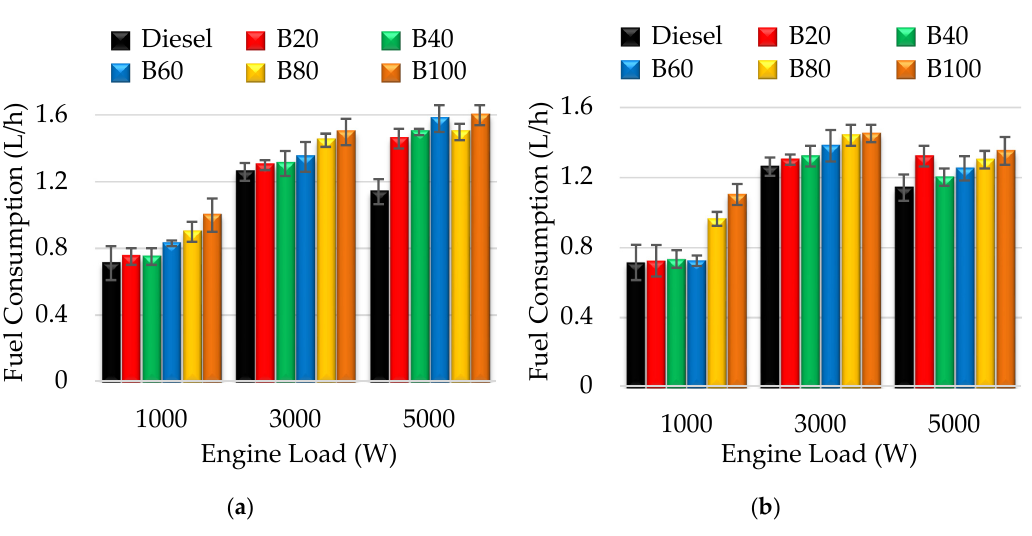
Figure 6. Fuel consumption values (L/h) at different engine loads (1, 3, and 5 kW) for ( a ) diesel/ethyl acetate/sunflower oil; ( b ) diesel/ethyl acetate/castor oil blends. The results are the average of three measurements and errors are represented as standard deviation through error bars.